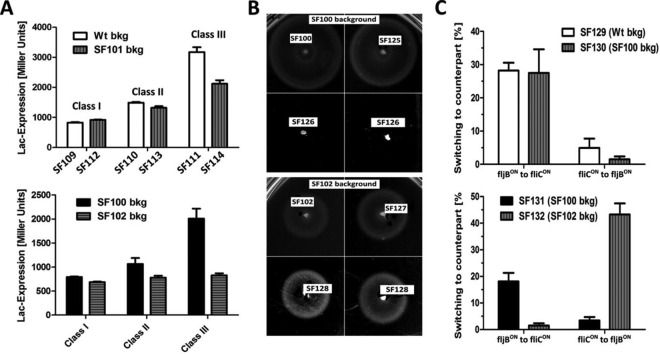
Flagellar phenotype of ΔaroA strains. (A) β-Galactosidase assay to measure activity of fusion of mudJ with genes of the different flagellar gene classes. Class I (flhDC5213-mudJ), class II (fliL5100-mudJ), and class III (fljB5001::mudJ Δhin5718::FRT) constructs were on a Wt (SF109, SF110, and SF111), SF101 (SF112, SF113, and SF114), SF100 (SF115, SF116, and SF117), or SF102 (SF118, SF119, and SF120) background (bkg), respectively. (B) Swimming assay for fliC deletion mutants SF126 (ΔlpxR9 ΔpagL7 ΔpagP8 ΔfliC::FCF) and SF128 (ΔlpxR9 ΔpagL7 ΔpagP8 ΔaroA ΔfliC::FCF) compared to parental strains SF102 and SF100, respectively. SF127 and SF125 served as positive controls for constitutively expressed fljB. (C) Preferential phase switching from fliC (Lac+) to fljB (Lac−) or vice versa. Lac+ or Lac− colonies were cultured and plated after 4 h on TTC (2,3,5-triphenyltetrazolium chloride) plates. The switching was assayed by counting Lac+ and Lac− colonies developed from either fliC or fljB strains. The means with standard deviations are displayed. Results are representative for two independent experiments with 5 biological replicates per group.